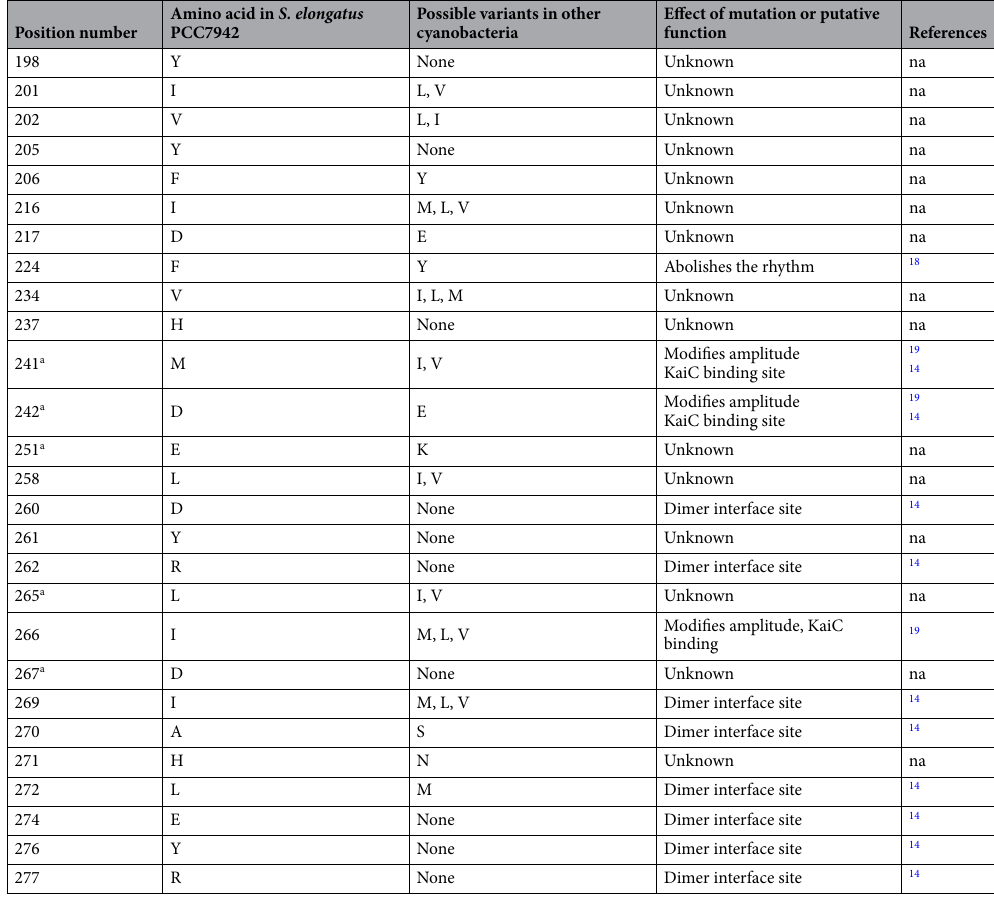
Table 1. A list of the universally conserved positions in the KaiA homologs of cyanobacteria with the reference to the bona fide protein of S. elongatus PCC7942. a Conserved in the truncated KaiA